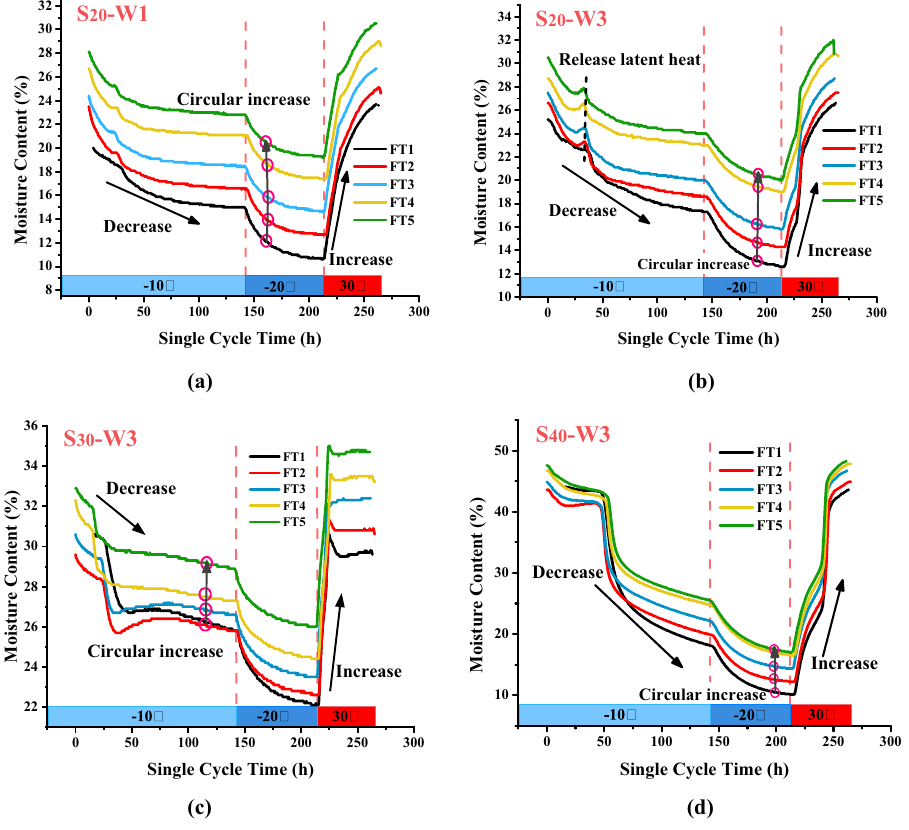
Figure 6. Moisture content in the slopes during freeze–thaw cycling (( a ) bottom of the S 20 slope; ( b ) top of the S 20 slope; ( c ) top of the S 30 slope; ( d ) top of the S 40 slope).